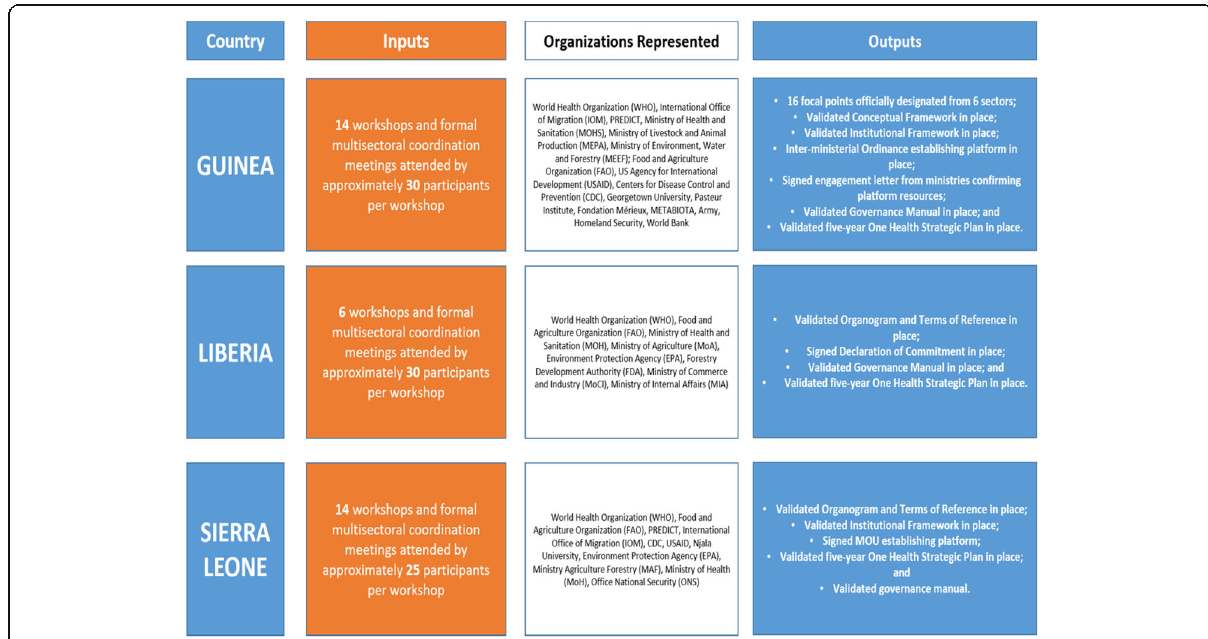
Fig. 4 Summary of Key Inputs and Outputs of the National One Health Platforms in Guinea, Liberia, and Sierra